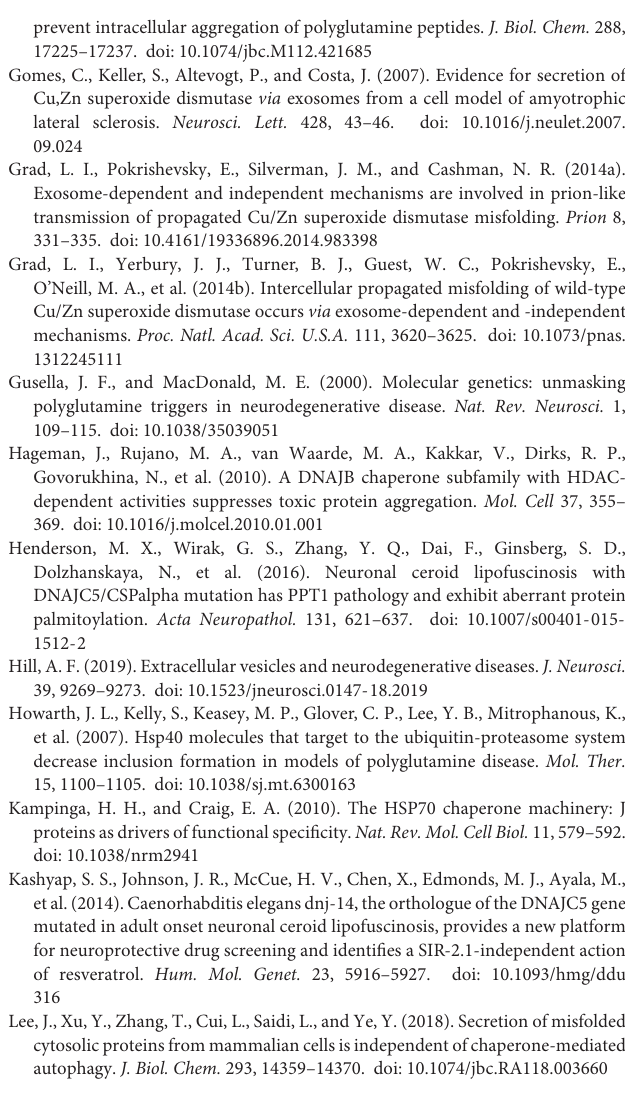
Supplementary Figure 1 | (A) Scatter of microflow cytometry size standards including both fluorescent latex and non-fluorescent silica standards ranging in size from 110 to 1,300 nm. (B) Red lines illustrate the division of size ranges of detected EVs described in the text to carry GFP-tagged 72Q Htt exon1 cargo. (C) NTA size standards (mean) included 60, 200, and 400 nm polystyrene NIST size standards as well as a 100 nm silica size standard. Supplementary Figure 2 | (A) NTA analysis of anti-CD36FITC antibody aggregation. (B) Line graph of the time dependent aggregation of anti-CD36-PE antibody. (C) NTA profiles of anti-CD36-FITC (or PE) antibody